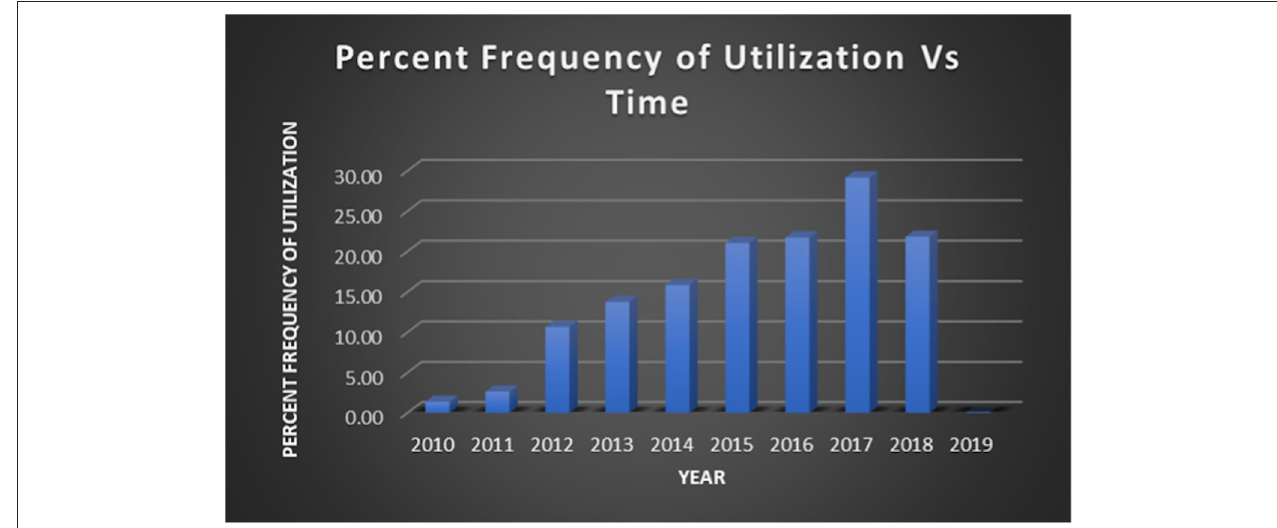
FIGURE 6 | Utilization of post-DCL CT over time from January 2010 to February